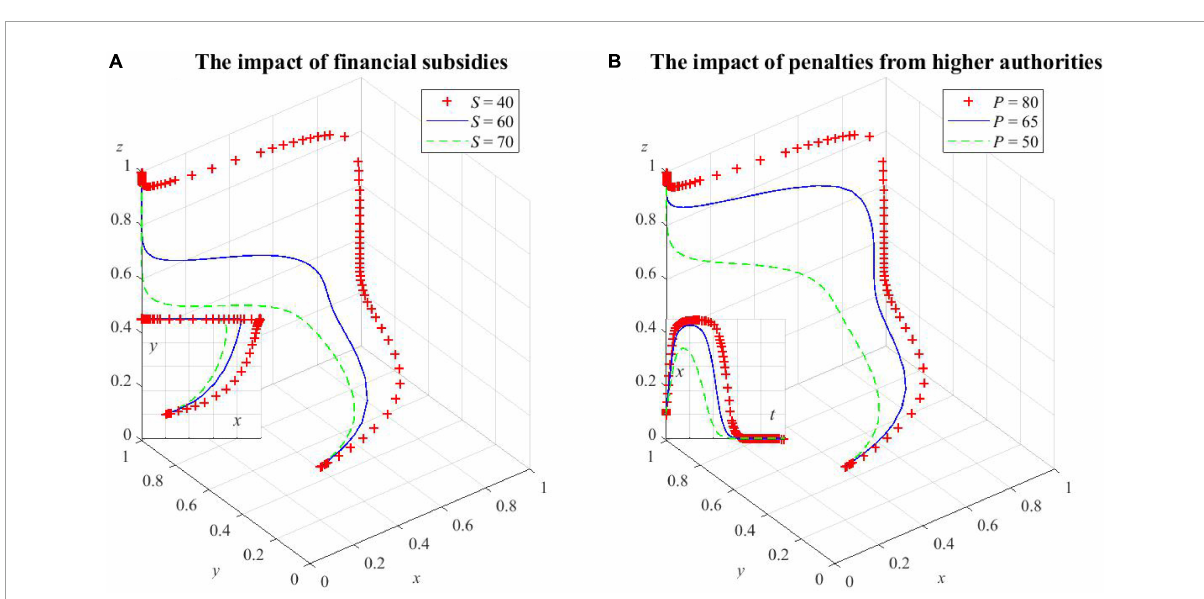
FIGURE5 The impact of factors on local government health departments’ decision making. (A) The impact of financial subsidies on health departments’ decision making, (B) the impact of penalties from higher authorities on health departments’ decision